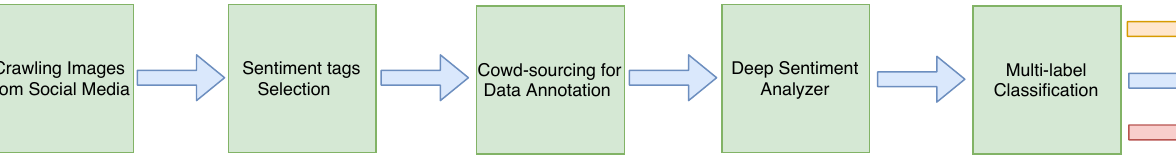
Figure 2. Block diagram of the proposed visual sentiment analysis processing